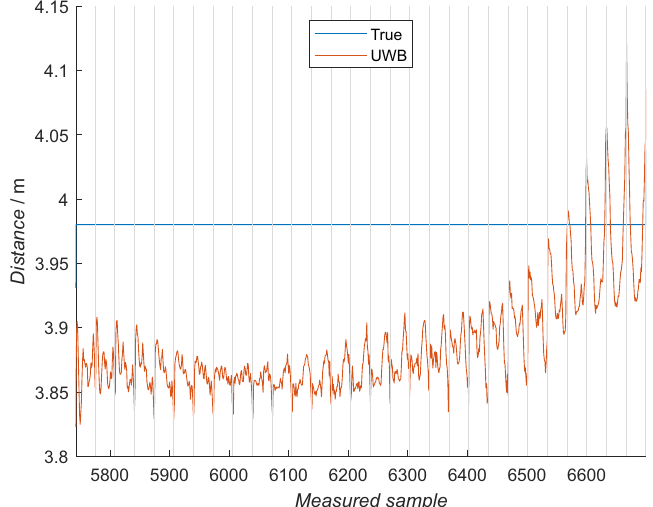
Figure 12. Zoomed training data acquired at 4-m distance, where a mean of 250 samples is presented for each azimuth and elevation point. Each gray compartment represents one azimuth sweep at a constant elevation, meaning the elevation is changing from − 70 degrees on the left to the 70 degrees on the graph’s right-hand side. In each compartment, the azimuth goes from − 80 degrees on the left-hand side to the 80 degrees on the right-hand side. The blue line represents the reference